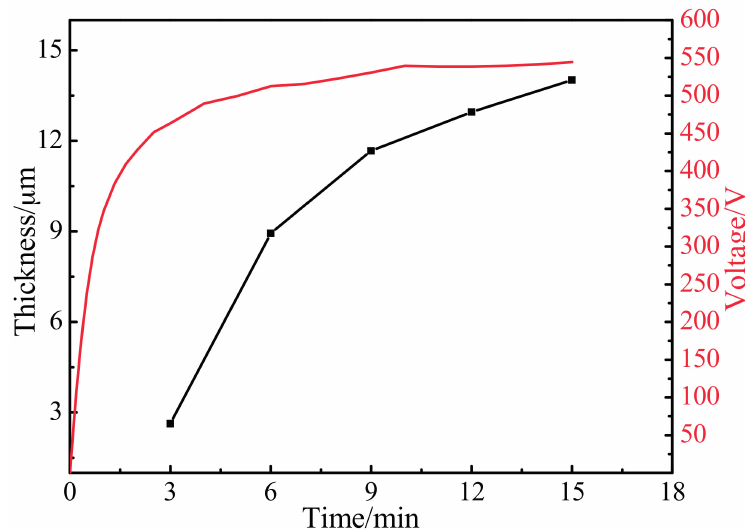
Figure 3. Variation of MAO coating thickness and voltage at different oxidation